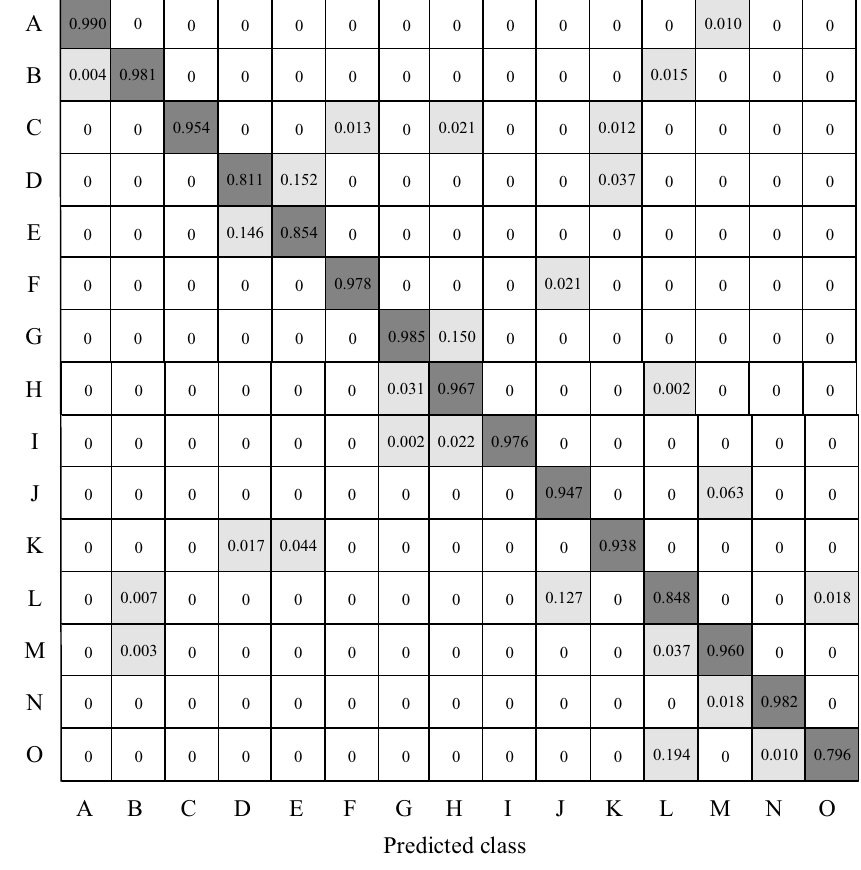
Figure 9. Confusion matrix of assembly behaviors.